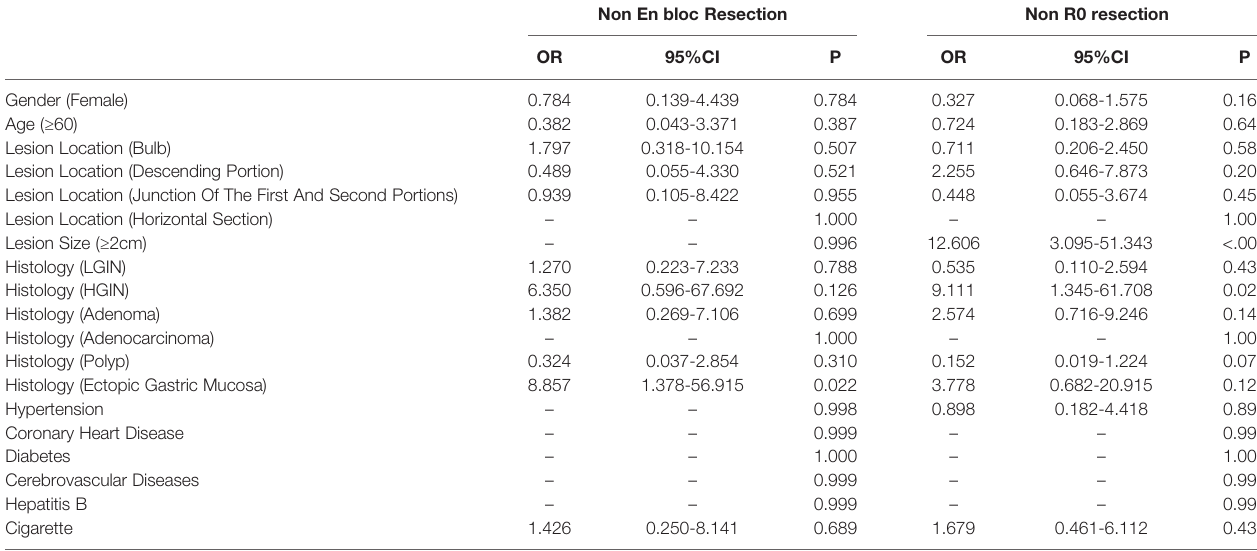
TABLE 3 | Univariate logistic regression of ef fi cacy indexes.